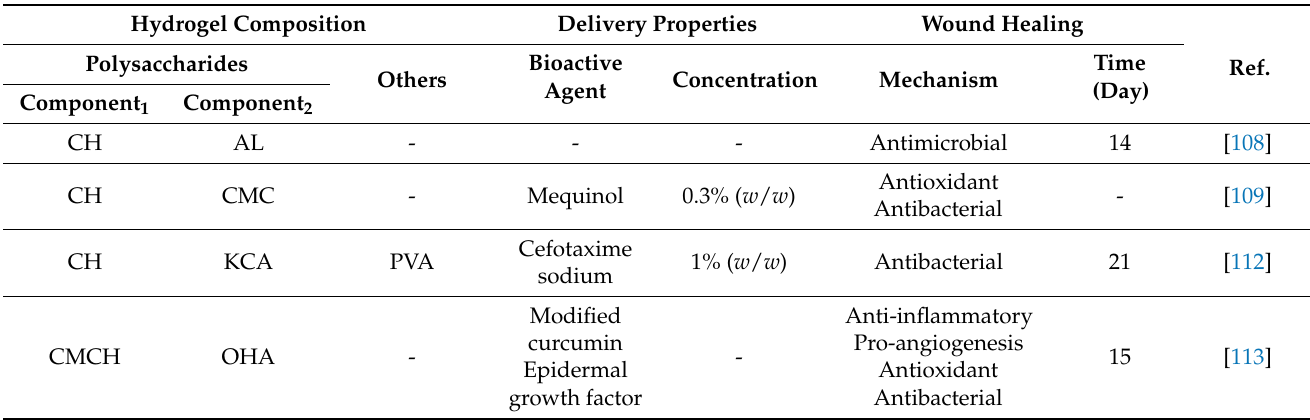
Table 7. Antibacterial polysaccharides-mixed hydrogels employed in the diabetic wound healing. Hydrogel